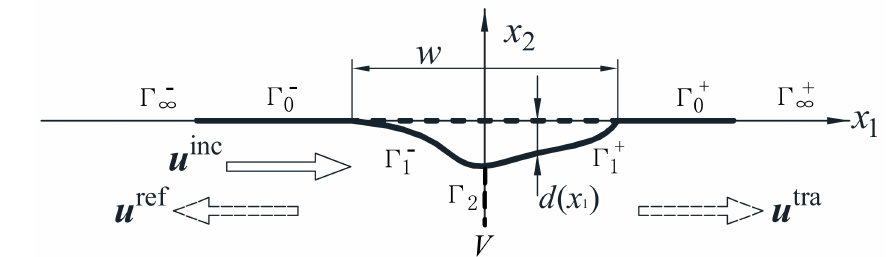
Figure 1. Problem configuration.